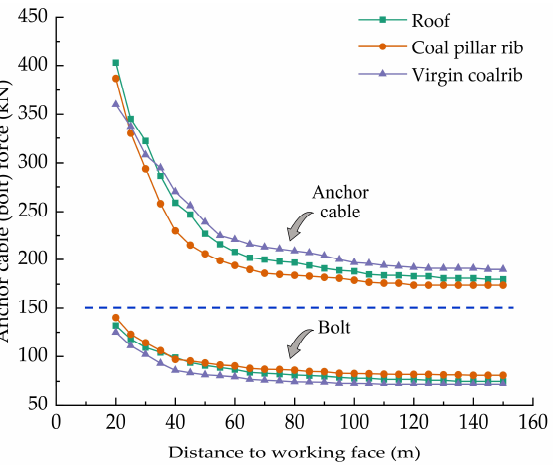
Figure 17. Anchor cable (bolt) force at different distances from the working face.